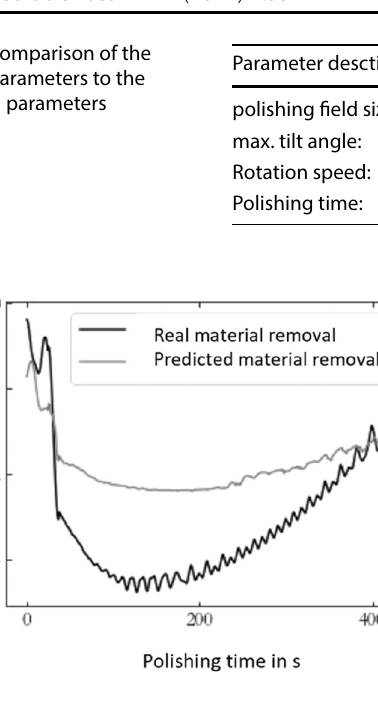
Fig. 4 Comparison of predicted material removal to the real mate- rial removal of the validation